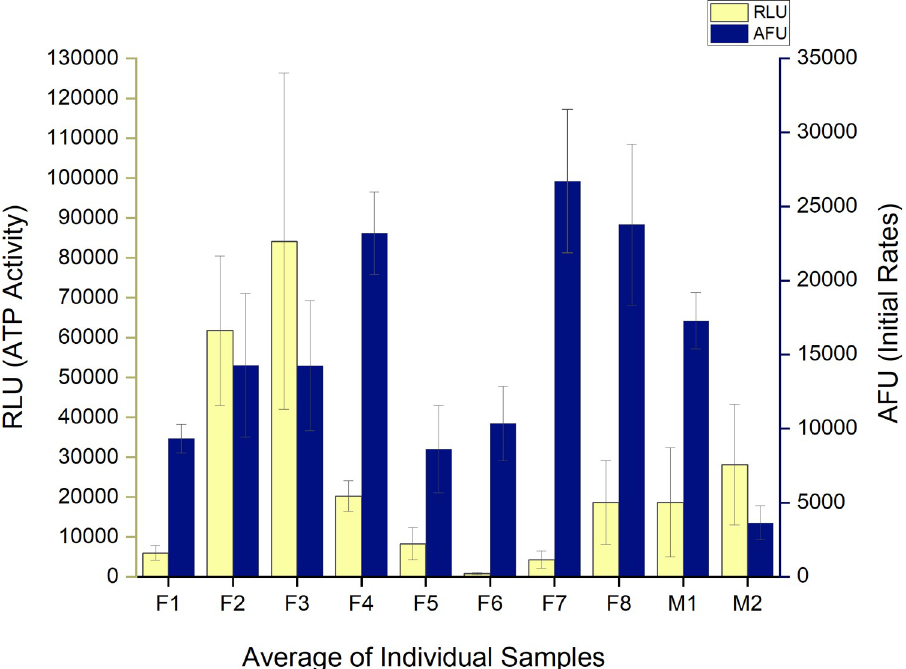
Fig 3. Viable cells and lysozyme activity in control samples. ‘ Comparison of averaged ATP activity and lysozyme initial rates in all 10 individual’s control saliva samples. Standard deviation of averaged sample sets indicated for both RLU and